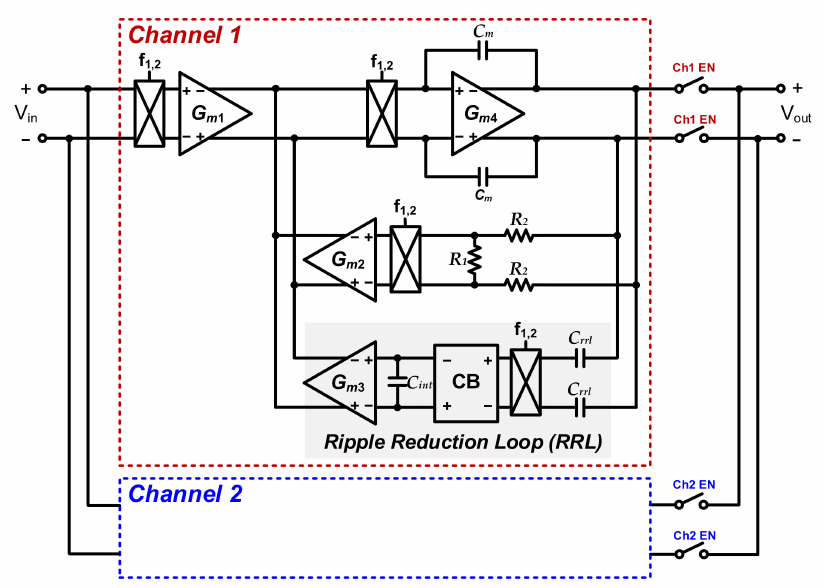
Figure 6. CFIA and RRL configuration in one channel.